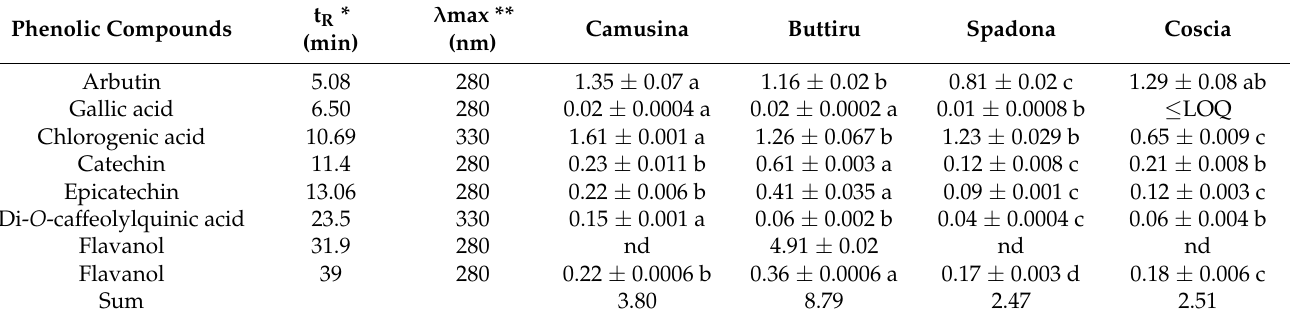
Table 7. HPLC analysis of individual phenolic compounds (mg g − 1 DM) in the fruit core of the investigated pear